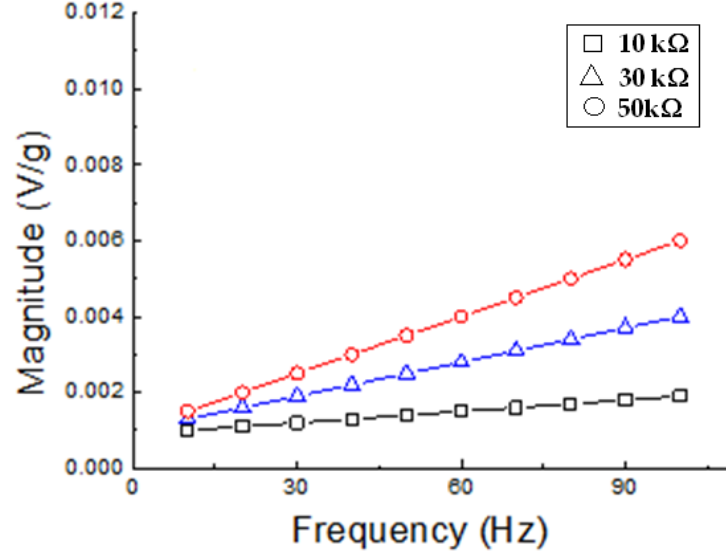
Figure 5. Frequency dependence of the investigated electromechanical properties upon dynamic stimulation for various values of loads and different samples .